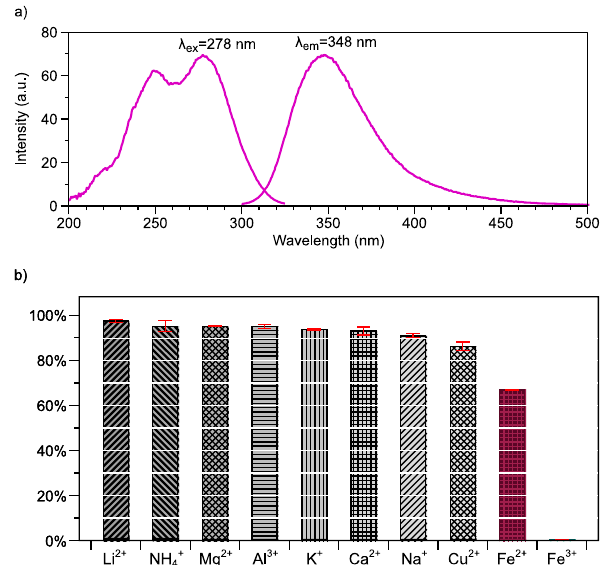
Figure 4. ( a ) Fluorescence spectrum of Poly(Ani-AMPS), ( b ) percentage of emission spectrum turn-off signal evaluating the Poly(Ani-AMPS) interaction with some ions.